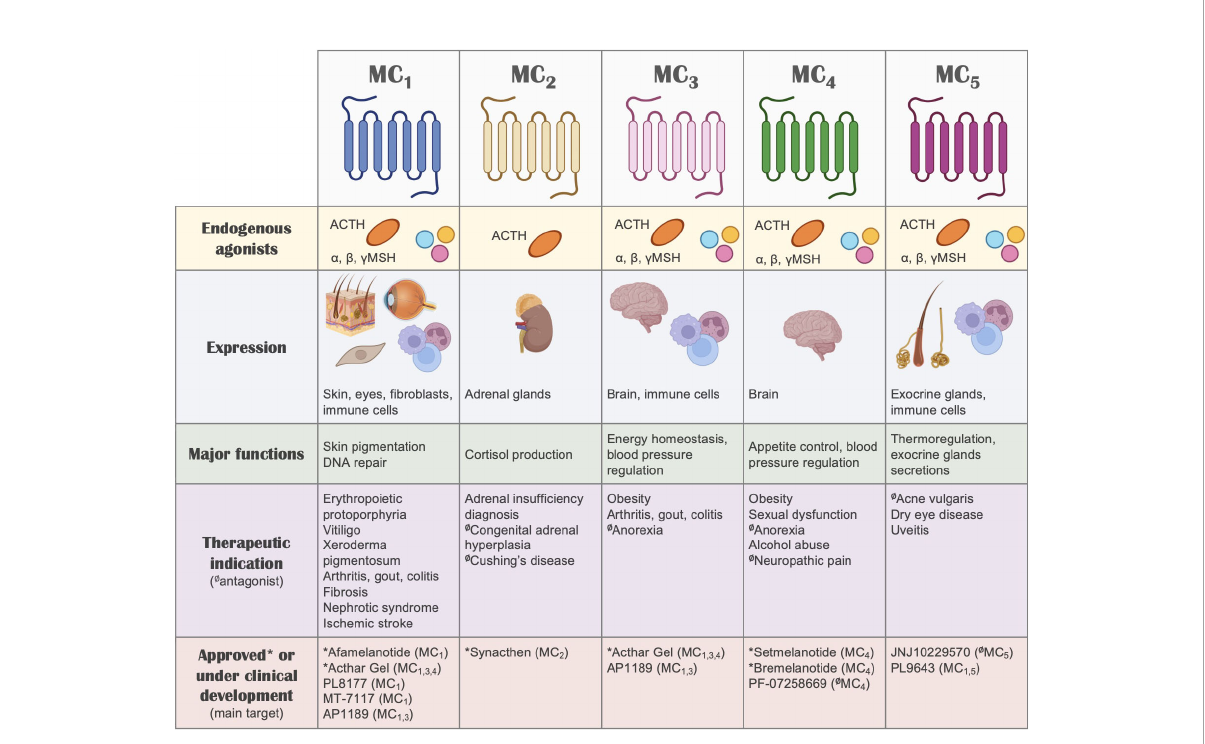
FIGURE 2 The melanocortin system. A summary of the melanocortin system is shown, including receptors, ligands, tissue distribution, their biological actions, potential therapeutic indication and drugs that are currently under clinical development or approved for use in humans. Regarding therapeutic indications, the receptor that mediates the therapeutic actions is highlighted, without implying receptor selectivity. Unless indicated otherwise (with the symbol Ø denoting antagonism), the molecules included in this summary are melanocortin receptor